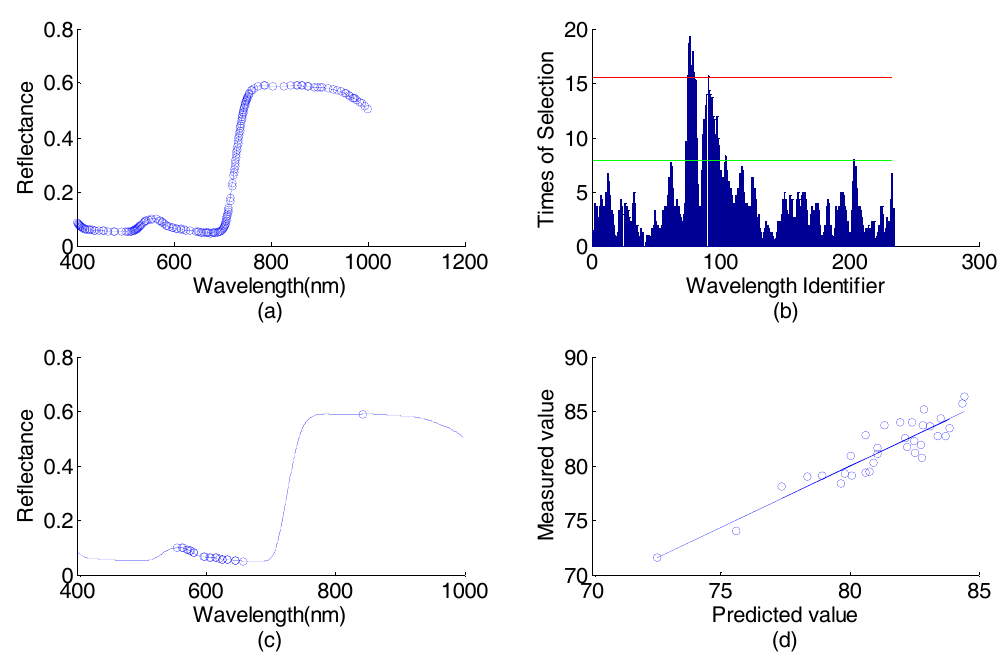
Figure 10. Sweet orange leaves data (predicting viscosity content) wavelength selection results in the first round: ( a ) spectral responses vs. wavelengths, the 234 wavelengths selected by AP-PN are marked with circles; ( b ) times of selection (by GA-PLS) vs. wavelength identifier (1–234); ( c ) spectral response vs. wavelengths, the 25 wavelengths selected by AP-PN-GA-PLS are marked with circles; ( d ) scatter plot of predicted values vs. the measured values.